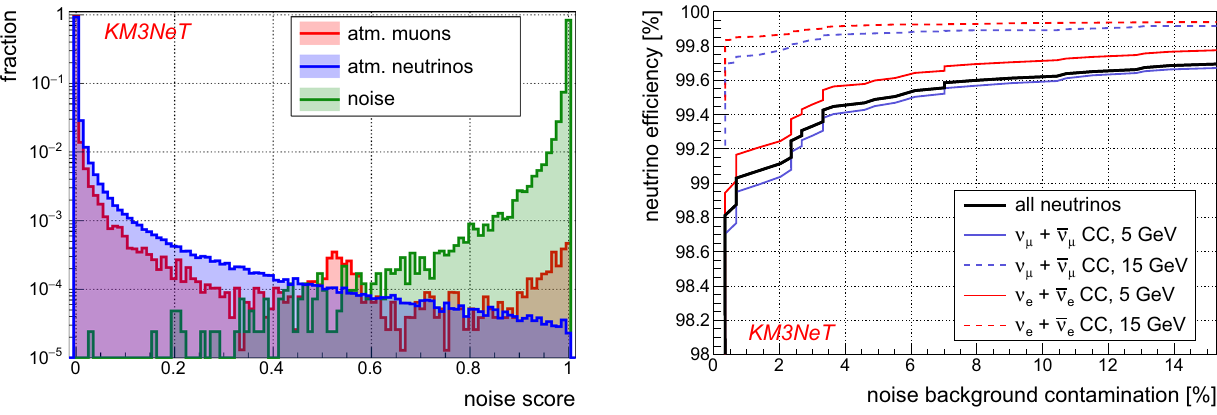
Fig. 5 Left: Distribution of the noise score variable for the RDF aimed to separate between neutrinos and pure noise, for the main classes of events. Right: Fraction of remaining atmospheric neutrinos versus noise event contamination in the final